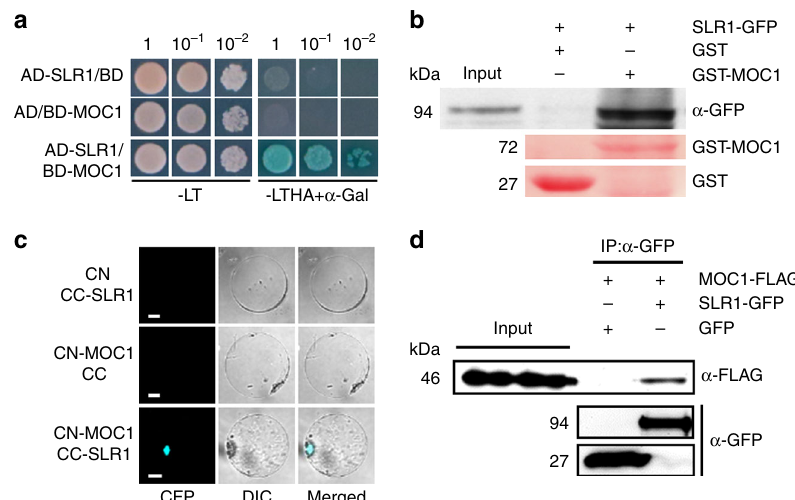
Fig. 3 Interaction between MOC1 and SLR1. a Interaction between MOC1 and SLR1 in the Y2H assay. Transformed yeast cells were grown on synthetic media lacking Trp and Leu (-LT); Trp, Leu, His, and Ade (-LTHA); or α -Gal and 5-bromo-4-chloro-3-indoxyl- α -D-galactopyranoside, a chromogenic substrate for α -galactosidase. The -LTHA + α -Gal medium contained 40 μ g·mL − 1 X- α -Gal. The numbers at the top indicate three serial dilutions. AD GAL4 activation domain, BD GAL4 DNA-binding domain. b Pull-down assay to test GST-MOC1 fusion protein or GST control interaction with SLR1-GFP using anti-GFP ( α -GFP) immunoblotting. Red images show staining with Ponceau S. c BiFC analysis of the interaction between MOC1 and SLR1 in rice protoplasts. Scale bar, 20 μ m. CC C-terminal portion of CFP, CN N-terminal portion of CFP. CFP fl uorescence and differential interference contrast (DIC) are shown separately and merged. d In vivo interaction between MOC1-FLAG and SLR1-GFP, revealed by the co-immunoprecipitation assay. After immunoprecipitation with anti-GFP ( α -GFP), precipitated proteins were probed with an anti-FLAG ( α -FLAG) antibody. Lower panels show SLR1-GFP and GFP controls. Source data are provided as a Source Data fi